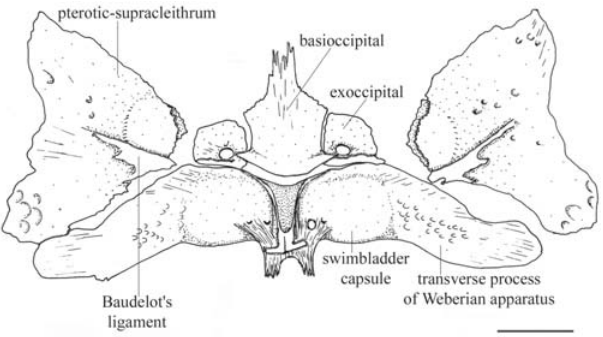
Fig. 38. Lateral view of sixth, seventh and eighth vertebra and predorsal plates (right side) of Lamontichthys filamentosus (LACM 41741-9, 119.4 mm SL) (a, scale bar = 2 mm), and Neoplecostomus ribeirensis (MZUSP 100920, 45.3 mm SL) (b, scale bar = 1